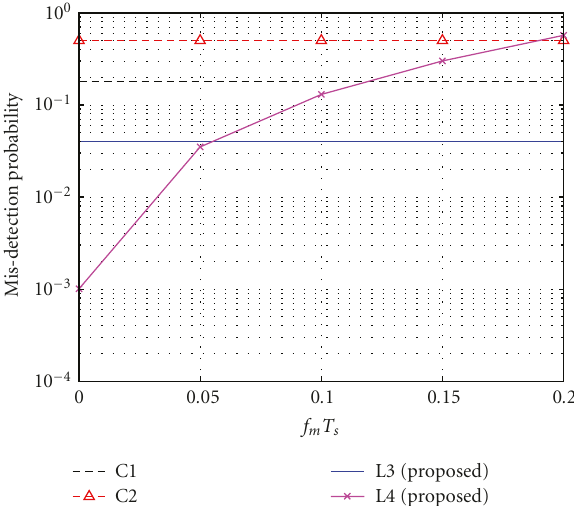
Figure 9: Detection performance under fading channel conditions (FAR = 10 − 3 , f m T s = 0 . 2, SNR =